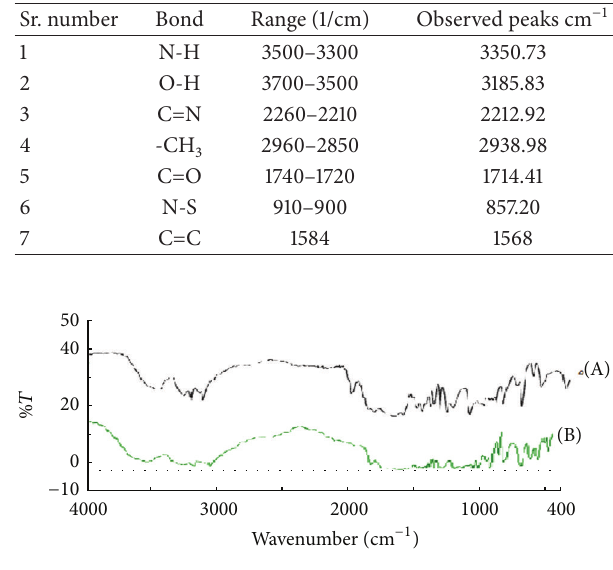
Figure 1: Infrared spectrum of (A) standard timolol maleate (IP) and (B) sample of timolol